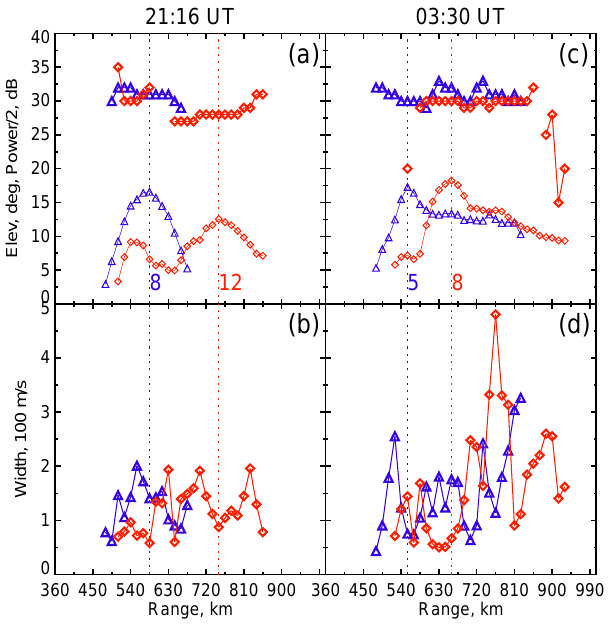
Fig. 5. Elevation angle (a) and (c) and spectral width (b) and (d) variations with range for the two intervals of interest. The measure- ments in two selected beams (the same as the last two from Figs. 2c, d and 3c, d) are shown by triangles and diamonds. The power pro- files (thin lines and symbols) scaled down by a factor of 2 are also shown in panels (a) and